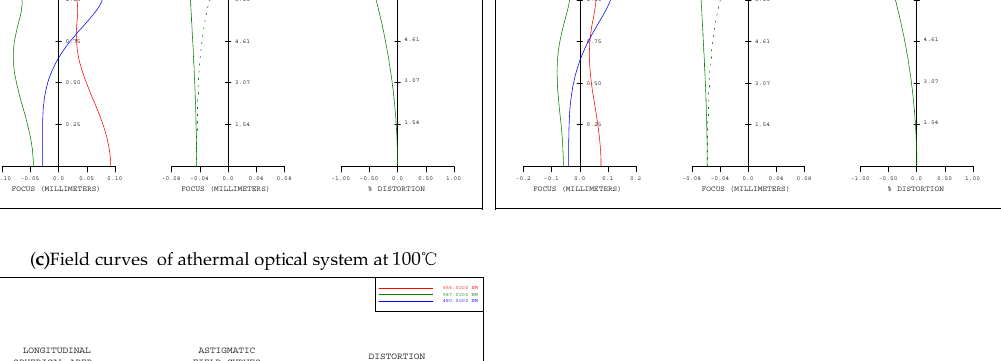
LONGITUDINAL LONGITUDINAL SPHERICAL ABER. SPHERICAL ABER.